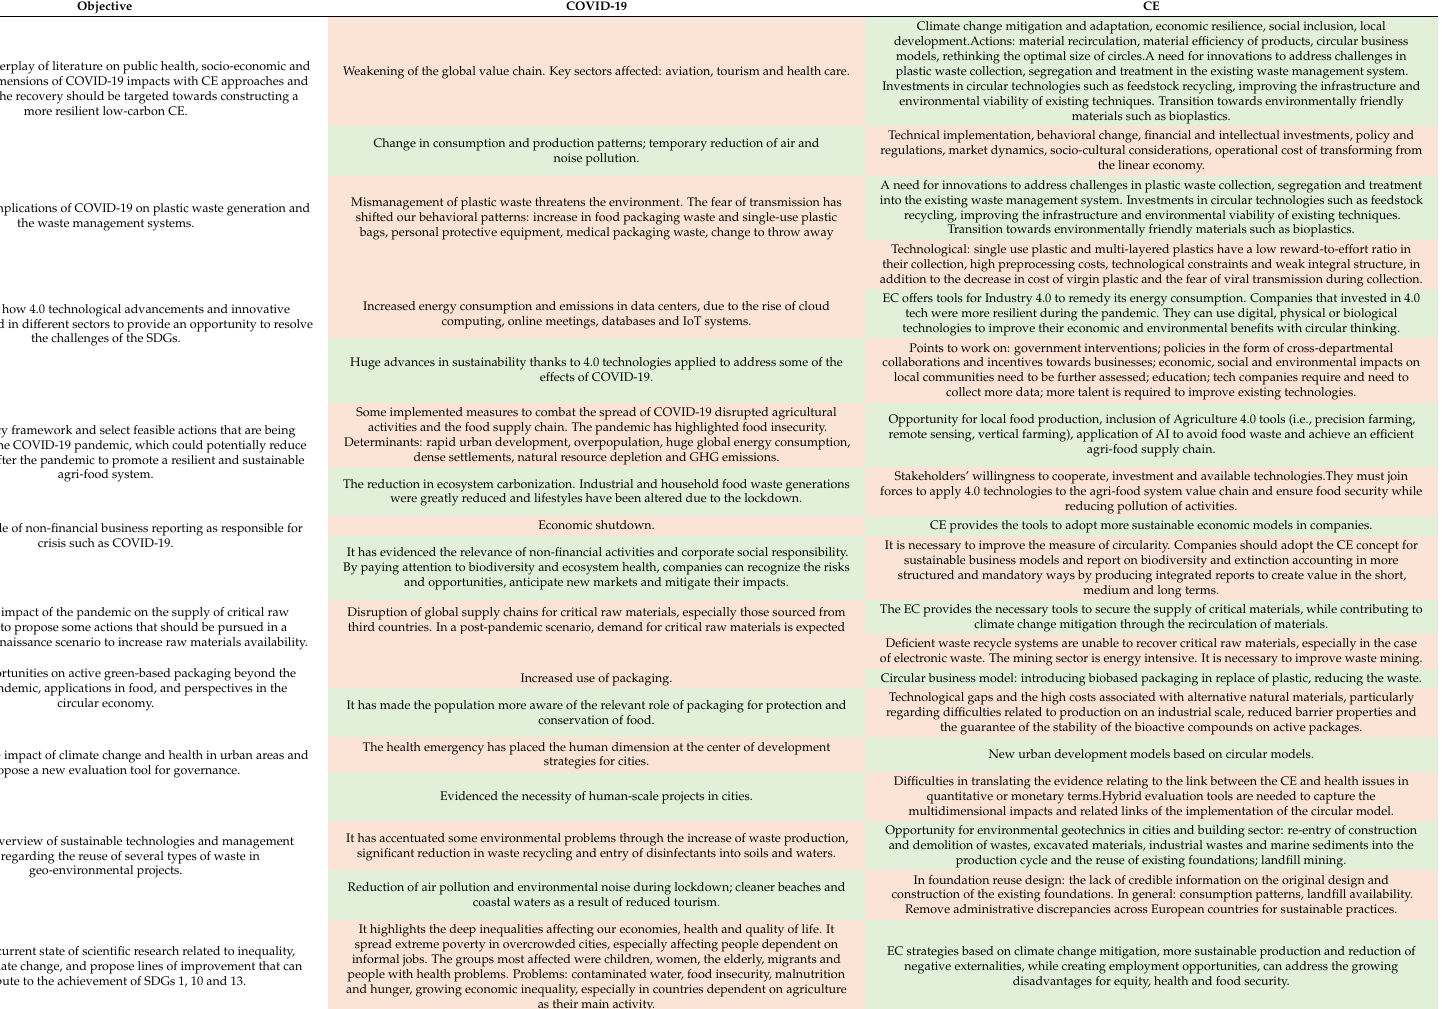
Table 8. The main contributions of the CE to the SDGs during